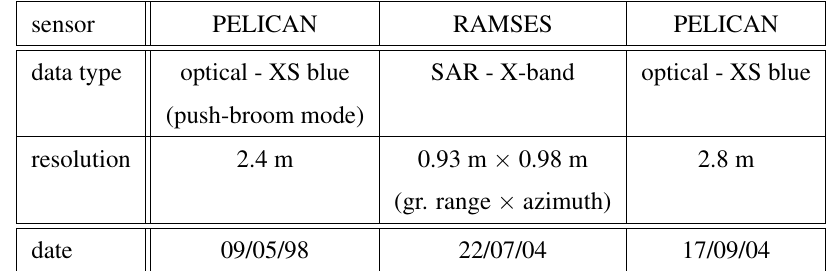
Table 1. Toulouse data set: images and sensors